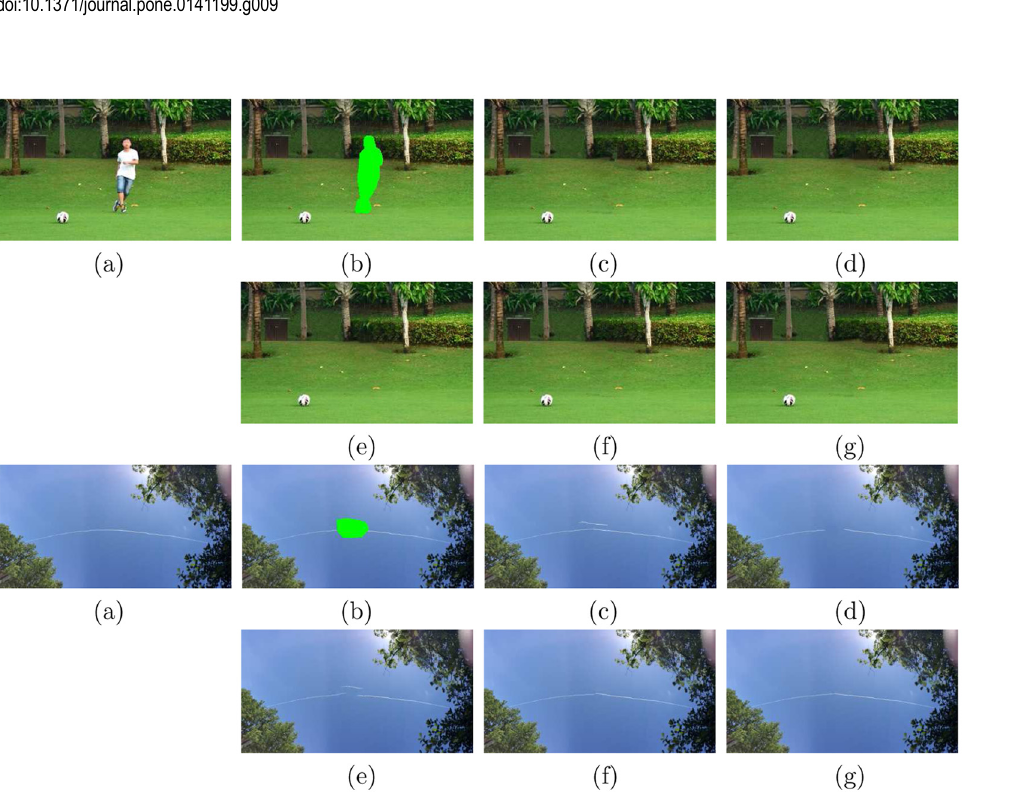
Fig 10. Test images from top to bottom: “ kicking ” (213 × 343) and “ sky ” (210 × 407). (a) The original images; (b) The original images with the red target regions; (c) Criminisi ’ s method “ 04 ’ TIP ” [23]; (d) The method “ 07 ’ TPAMI ” by Wexler et al. [18]; (e) Photoshop CS5 [16]; (f) The method “ 13 ’ TIP ” by Liu et al. [ 19]; (g) The proposed method. Note that the man in the first example is one of authors, he consents that the image is freely available. The individual in this manuscript has given written informed consent (as outlined in PLOS consent form) to publish these case